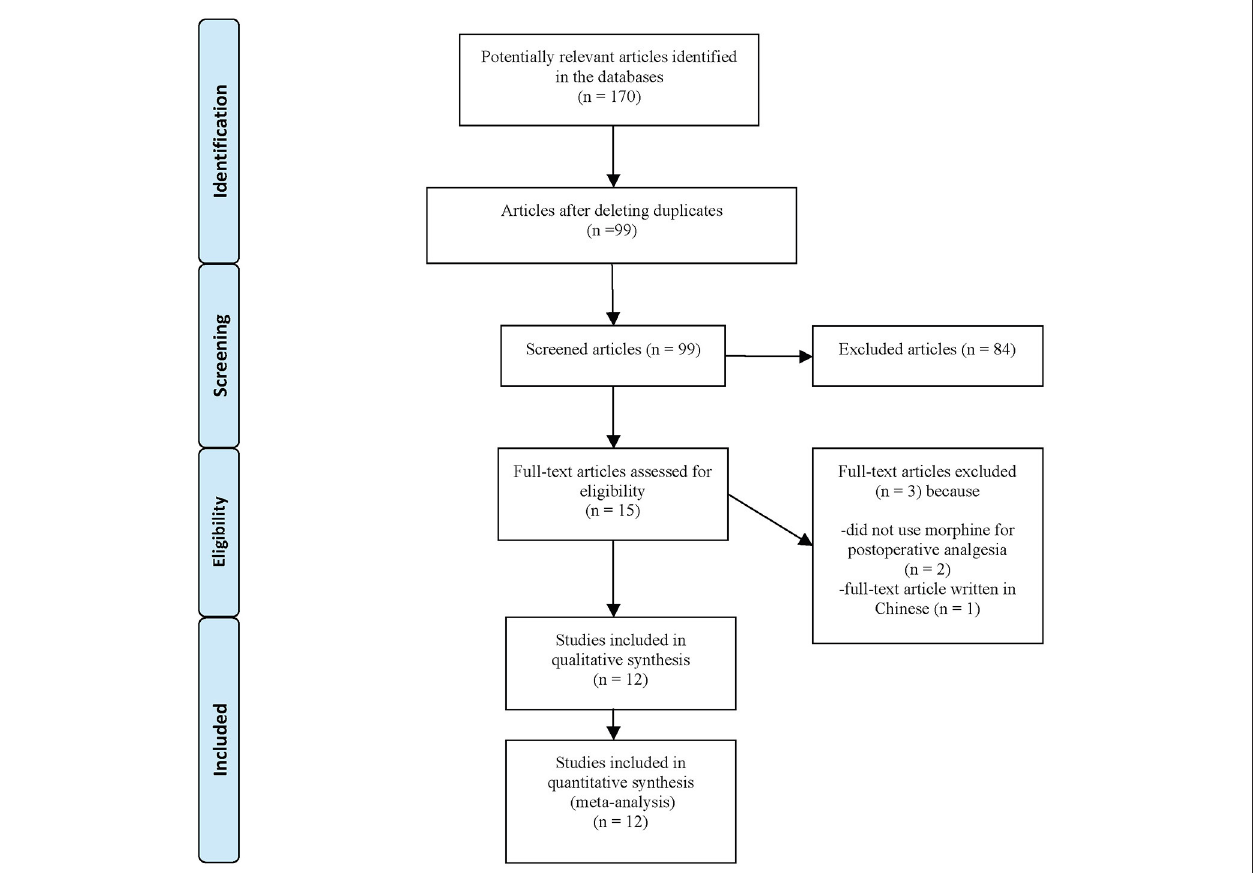
FIGURE 1 | Flow diagram of the different phases of the systematic